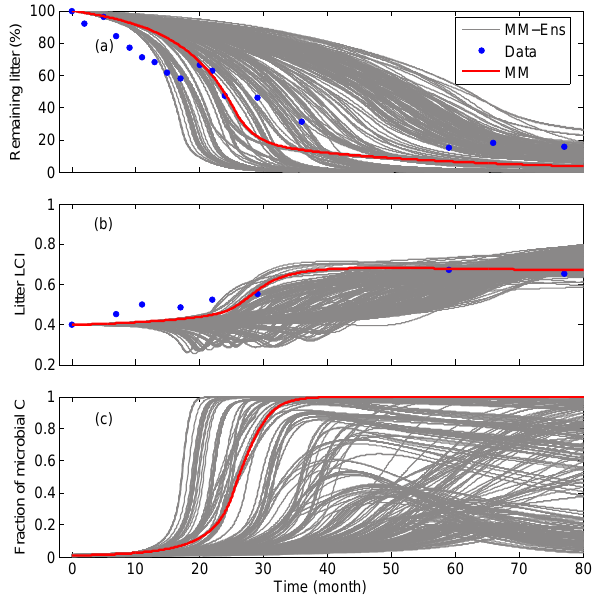
Fig. 12. Posterior S3B3-MM simulations by calibrating the model to the 77-month red pine litterbag experimental data in Melillo et al. (1989). MM-Ens indicates the posterior ensemble simulations. The best-fit posterior simulation is in red, whose corresponding pa- rameters are in Table S2.